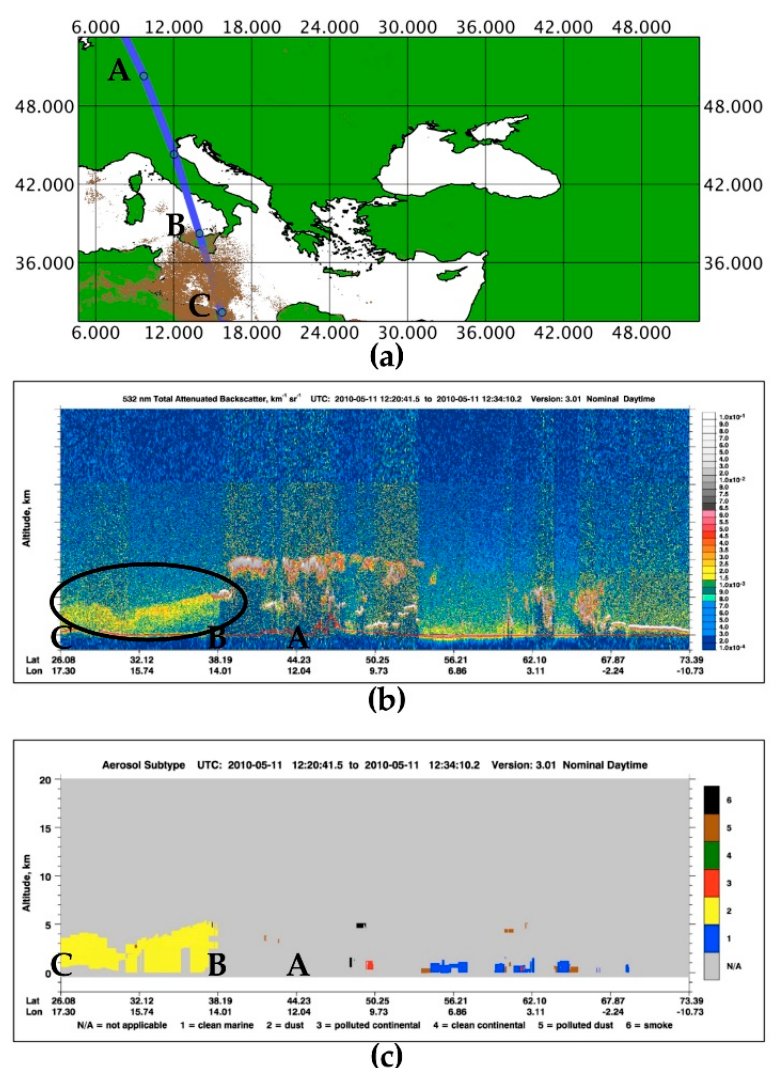
Figure 9. ( a ) Orbit track of CALIPSO (in blue) intersecting a number of dusty pixels (in brown) detected by e RST DUST (i.e., ⊗ VIS ( x,y,t ) > 0 ( L ), 1 ( S ) AND ⊗ TIR ( x,y,t ) > − 2 AND ⊗ Δ TIR ( x,y,t ) < − 1) on 11 May 2010 at 12:30 UTC; ( b ) Total Attenuated Backscatter profile acquired the same day between 12:20 and 12:34 UTC; ( c ) CALIOP aerosol sub-type profile.